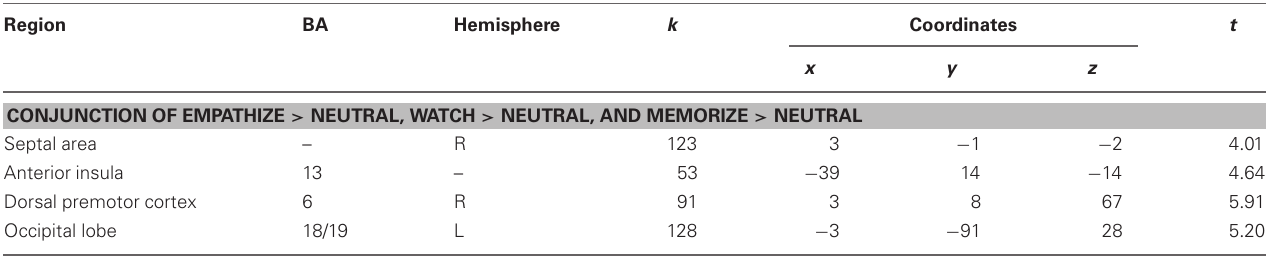
Table 8 | Neural regions that were commonly activated during empathize, watch, and memorize (collapsed across emotions) compared to neutral.